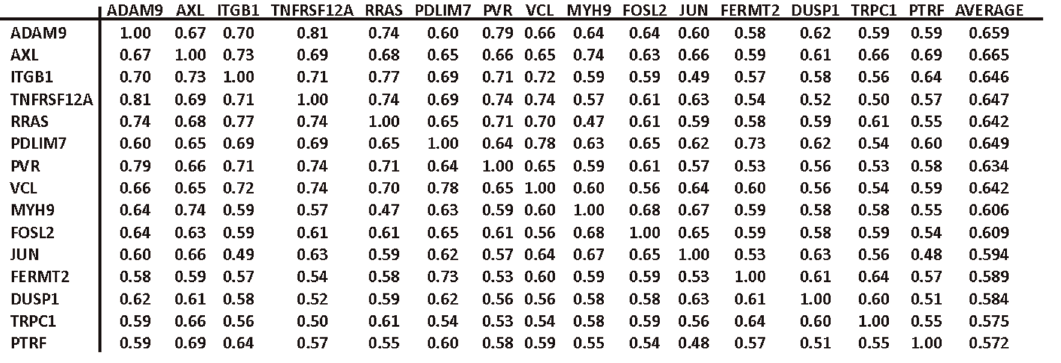
Figure 2. High cross-correlation set of 15 genes (HCCS15) derived from cluster 52/160. The genes marked with an asterisk (*) are discussed in the current report and are included in the molecular interaction maps (Figures 11 and 12). The other genes in the table function in other aspects of cell migration that are not covered in the present report. The numbers in the table are expression profile correlations for expression of gene pairs in the NCI-60 human tumor cell lines (expression profile correlation . 0.50 corresponds approximately to P , 0.001; expression profile correlations . 0.60 are almost never due to chance alone).